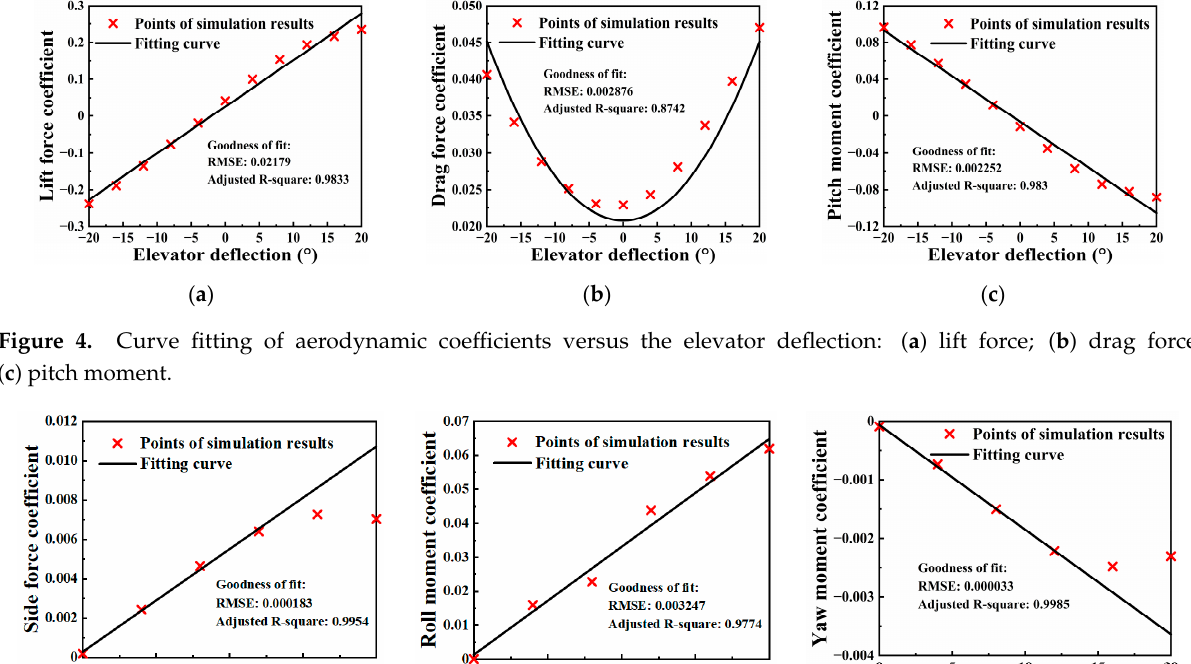
Figure 5. Curve fitting of aerodynamic coefficients versus the aileron deflection: ( a ) side force; ( b ) roll moment; ( c ) yaw